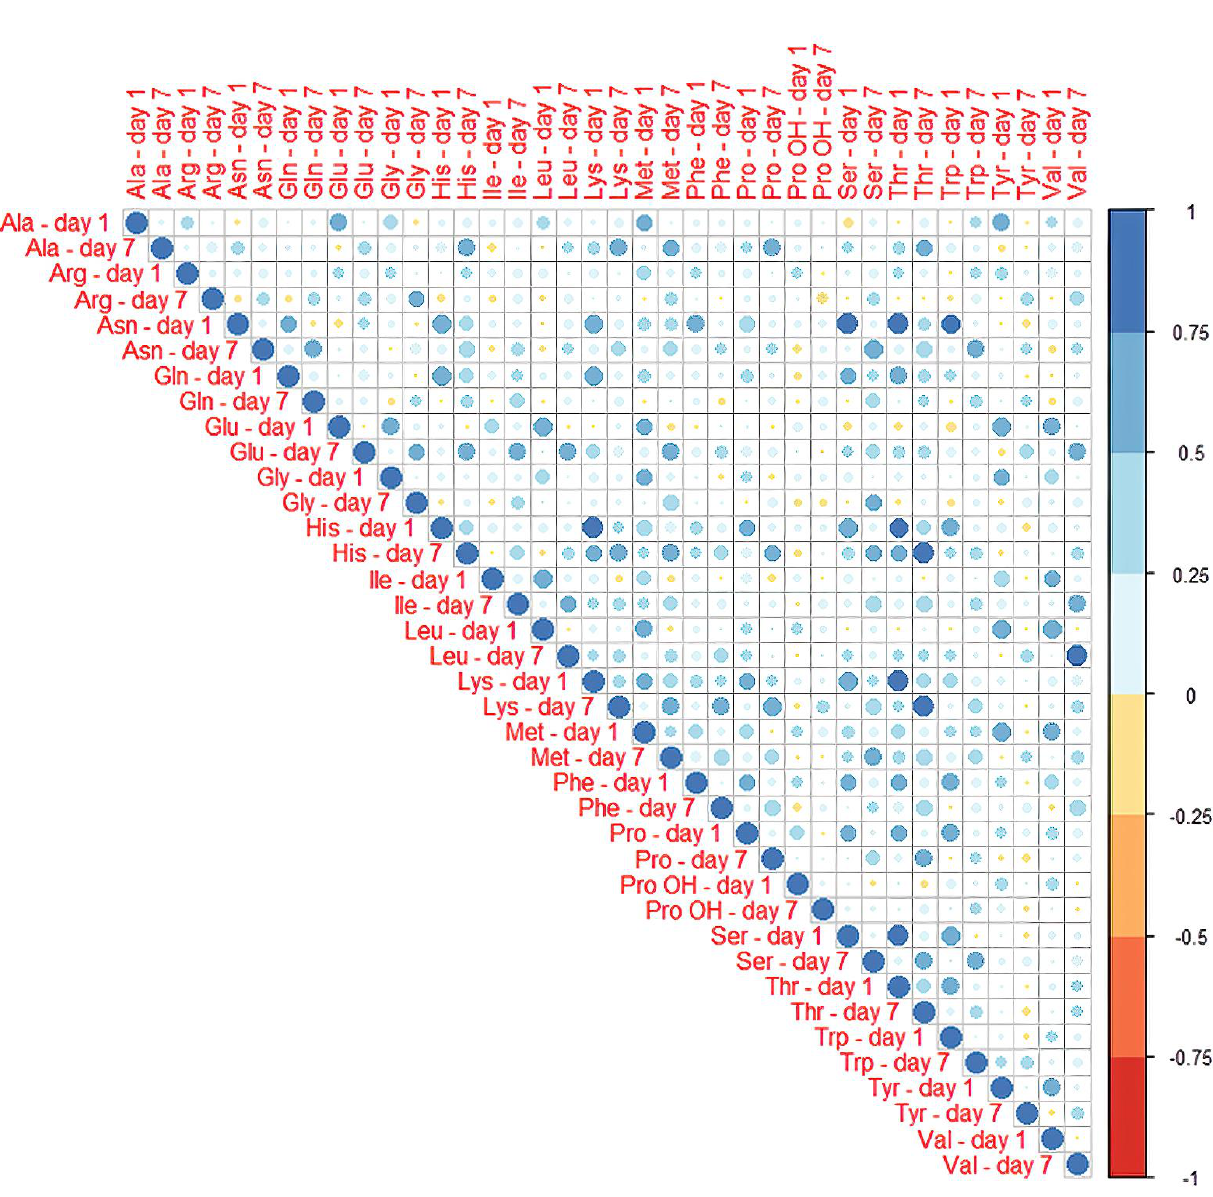
Figure 3. Correlations between amino acids concentration in patients with SAH and between postoperative day one and day seven. Scale presents the value of R coefficient, indicating the strength of the correlation.